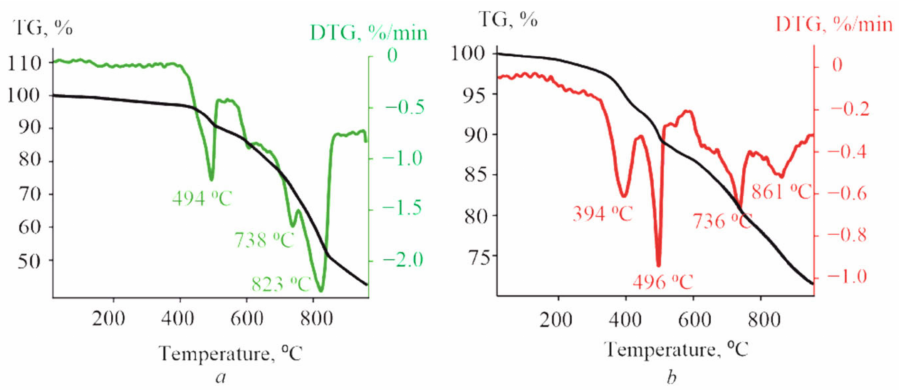
Figure 8. The TG and DTG curves for the (C 60 ) 2 CoTTP ( a ) and (PyC 60 ) 2 CoTTP ( b ) powder from 25 ◦ C to 920 ◦ C. The heating rate is 10 ◦